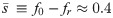
Negative selection on reassortment.(a) The cumulative distribution of mean nucleotide distances d between reassortant and parent strains for the HA-NA reassortments in influenza A/H3N2 (red line) is compared to the corresponding distribution of distances for co-circulating strains in the same influenza season (solid blue line) and from the New York area only [28] (dashed blue line). (b) The ratio of reassortment counts to background counts in the interval d ≥ dmin (red circles) decreases with increasing lower threshold dmin and drops significantly below 1 (blue line). The suppression of reassortment at larger values of d signals distance-dependent negative selection. Bars show statistical errors due to the finite number of inferred reassortments. (c) The average number of strains in the reassortant clades with nucleotide distance ≤ τ from the focal node, 〈Nr〉(τ) (red line) is compared to the corresponding average number of strains in the parent clades, 〈N0〉(τ). For τ ≲ 6, both functions increase with τ in an approximately exponential way; we estimate growth rates fr ≈ 0.07 and f0 ≈ 0.5, respectively (dashed lines; cf. Eq 1). The growth rate difference s¯≡f0-fr≈0.4 measures the average fitness cost of reassortment. Bars represent statistical errors due to the finite number of counts (not shown when these errors are smaller than the dot size). See S3 Fig for an analogous inference based on amino acid distances.